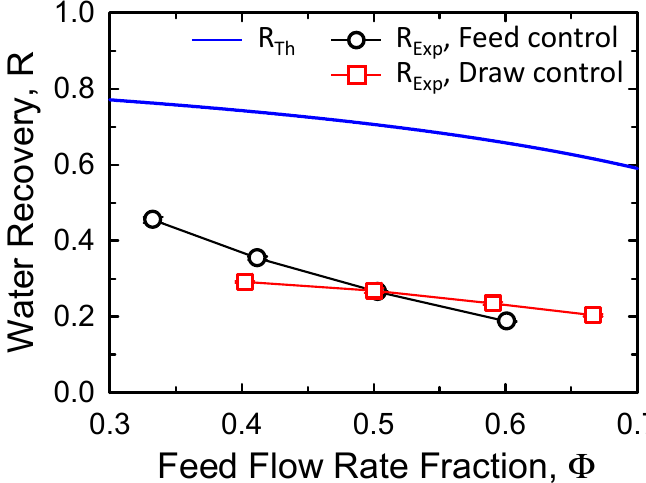
Figure 6. Water recovery as a function of the feed flow rate fraction with feed flow rate control or draw flow rate control. When the feed or draw flow rate was adjusted from 5 to 15 LPM, the other stream was fixed to 10 LPM. One SW FO element (15.3 m 2 ) was used with concentrations of 10 g/L and 1 M NaCl for the feed and draw solutions, respectively. The error bars represent one standard deviation.